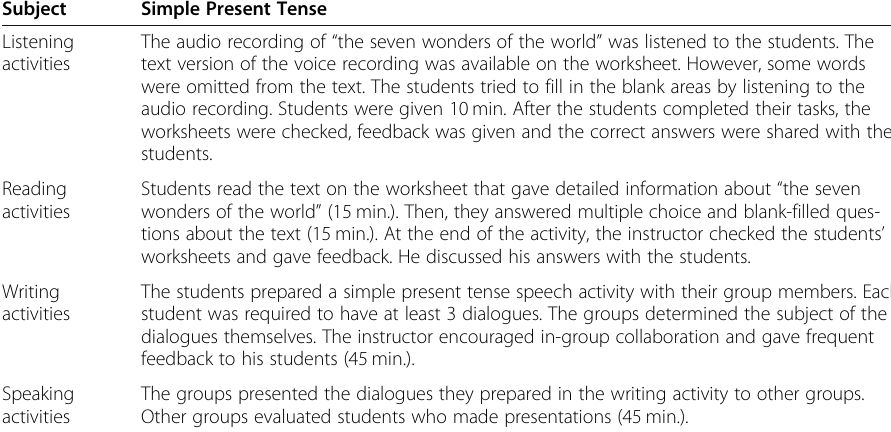
Table 7 Experimental group activity example in the 3rd